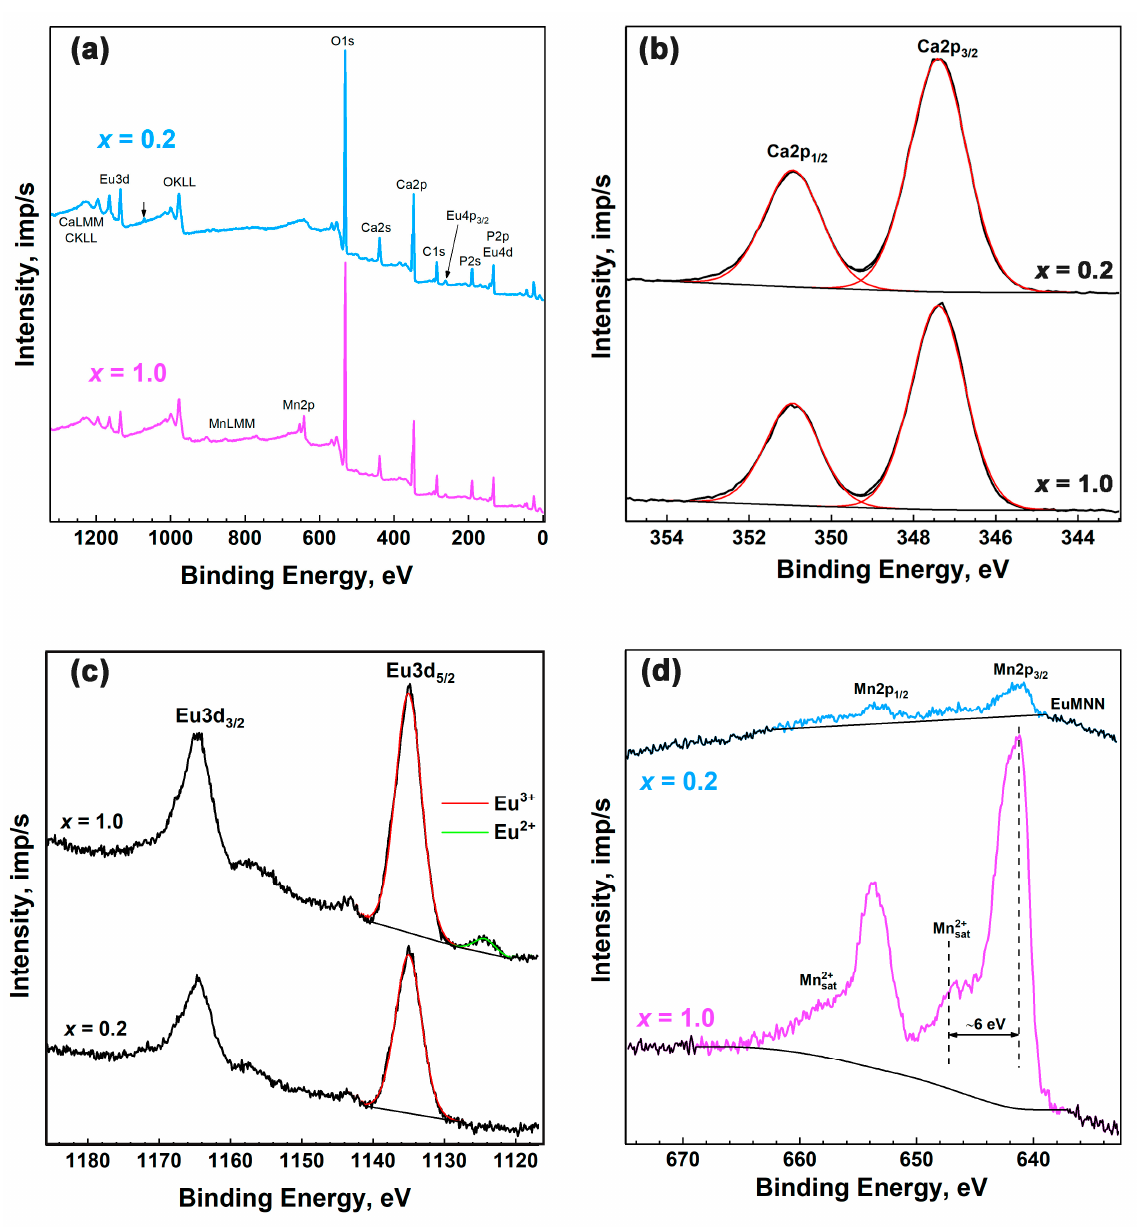
Figure 9. The XPS survey spectrum ( a ) and high-resolution XPS spectra of Ca2p ( b ), Eu3d ( c ) and Mn2p ( d ) peaks of Ca 9 − x Mn x Eu(PO 4 ) 7 with x = 0.2 and 1.0.